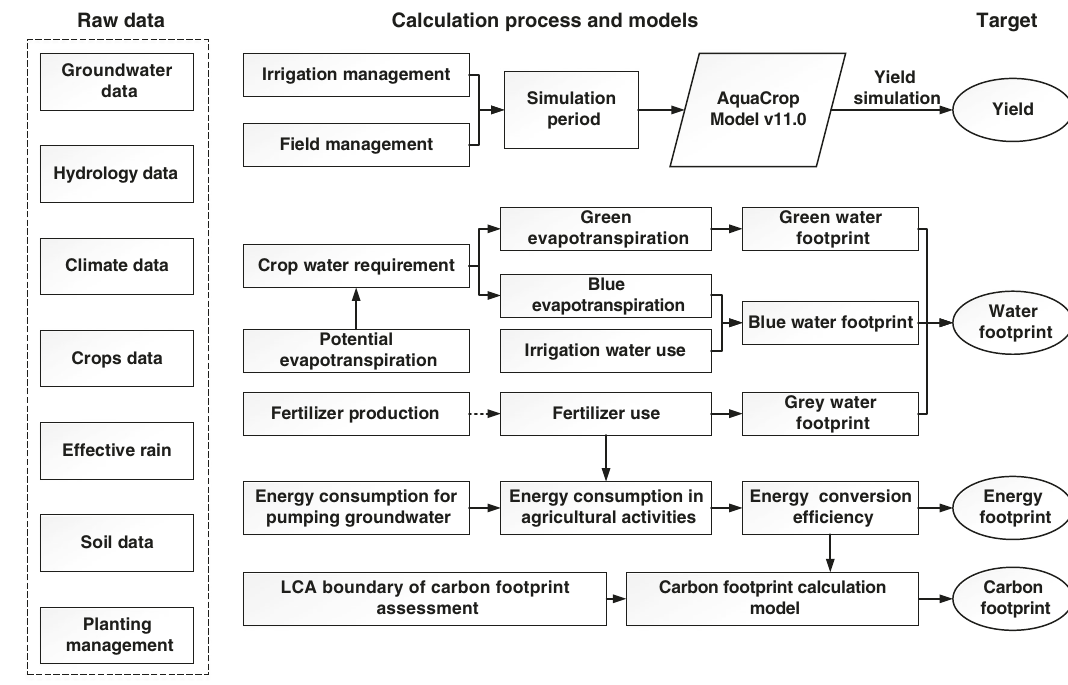
Fig. 5 Framework for footprint evaluation model based on LCA. Framework of crop production simulation and water, energy, and carbon footprint assessment in the North China